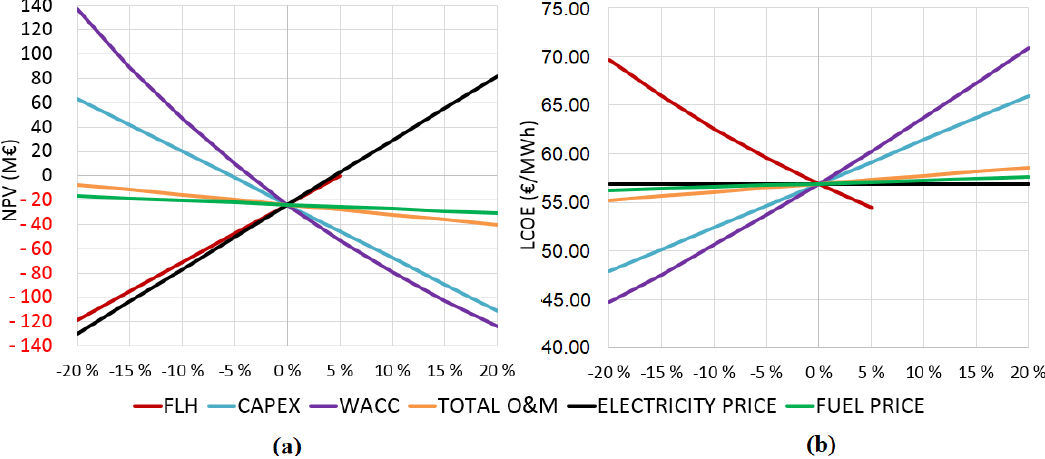
Figure 13. The NPV ( a ) and the LCOE ( b ) values from the sensitivity analysis performed on the additional investment towards a SMR CHP